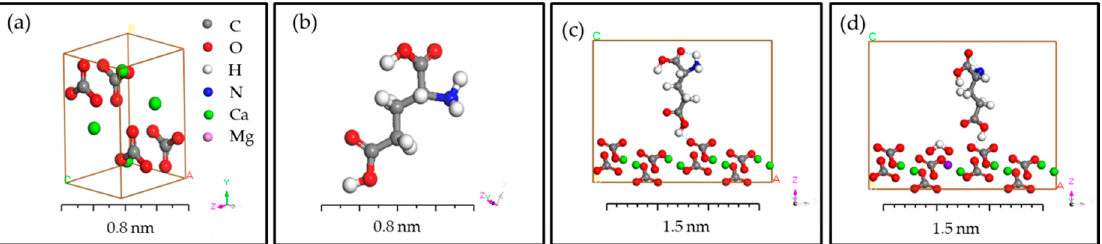
Figure 11. Amino acid composition of EPS secreted by YXY2 bacterium and that of the organic substances within the biotic aragonite minerals.